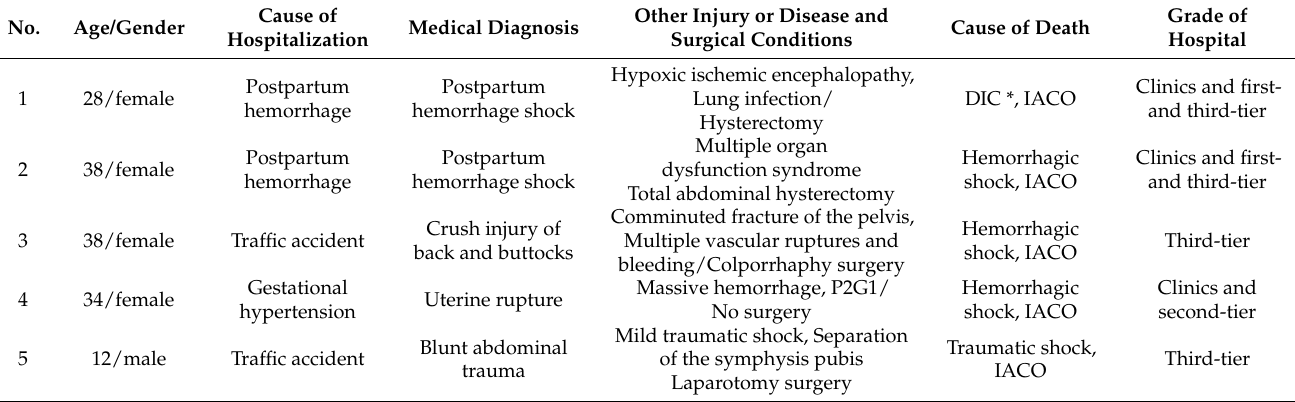
Table 1. The demographic characteristics of the 16 cases of massive fluid infusion.